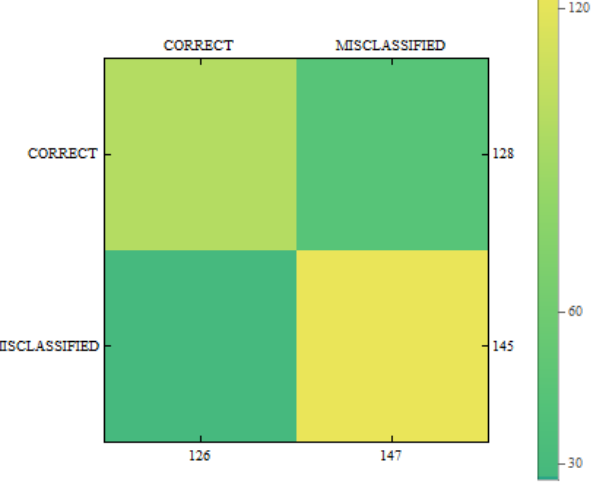
Figure 13. Confusion matrix for measurements obtained by the classifier using PH2 Dataset and created images from the proposed